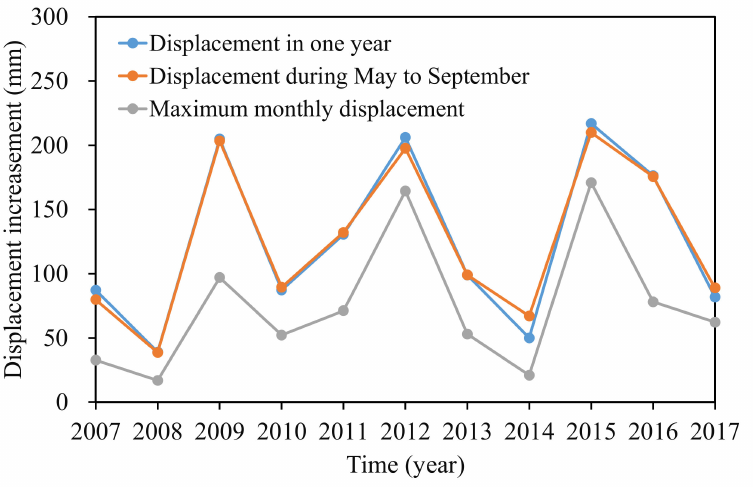
Figure 10. Annual displacement increment, displacement during step-wise deformation period, and the maximum monthly displacement at ZG324, Baijiabao